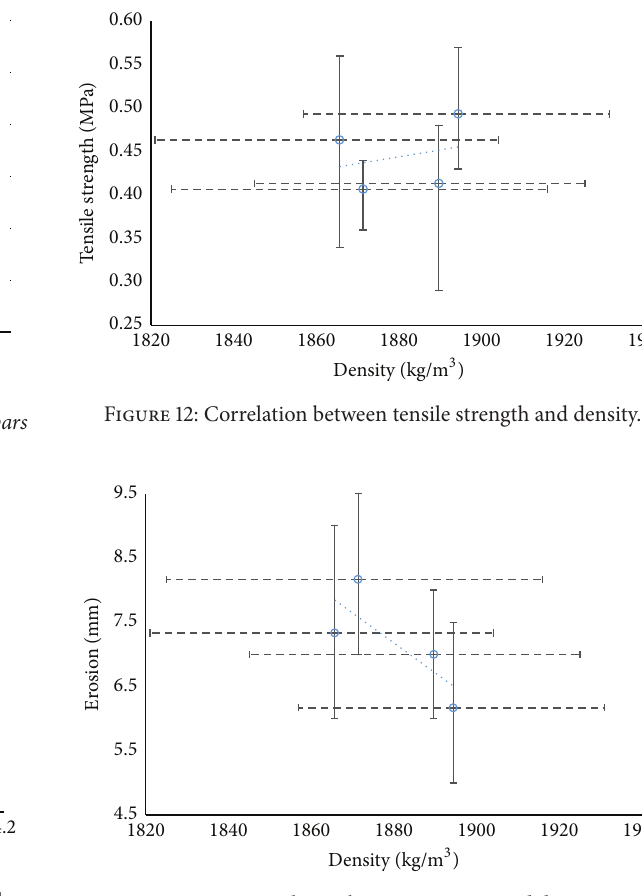
Figure 13: Correlation between erosion and